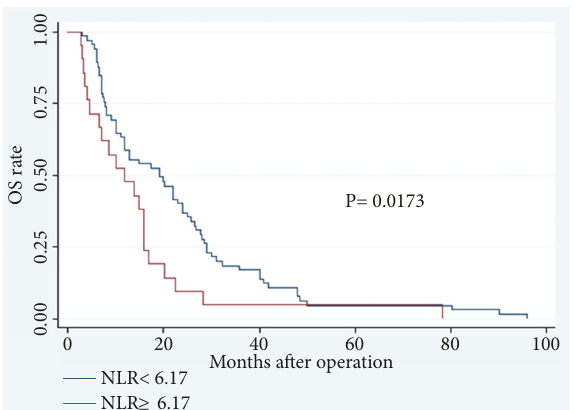
Figure 5: Overall survival in patients with cholangiocarcinoma according to NLR levels (P=0.0173) (NLR, neutrophil-lymphocyte ratio; OS, overall